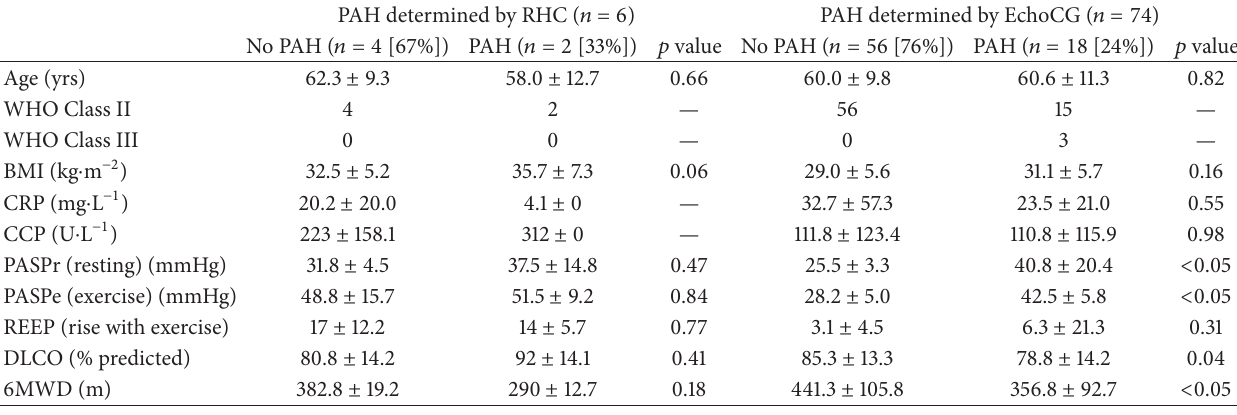
Table 2: Patient characteristics by PAH status ( 𝑛 = 80 ).